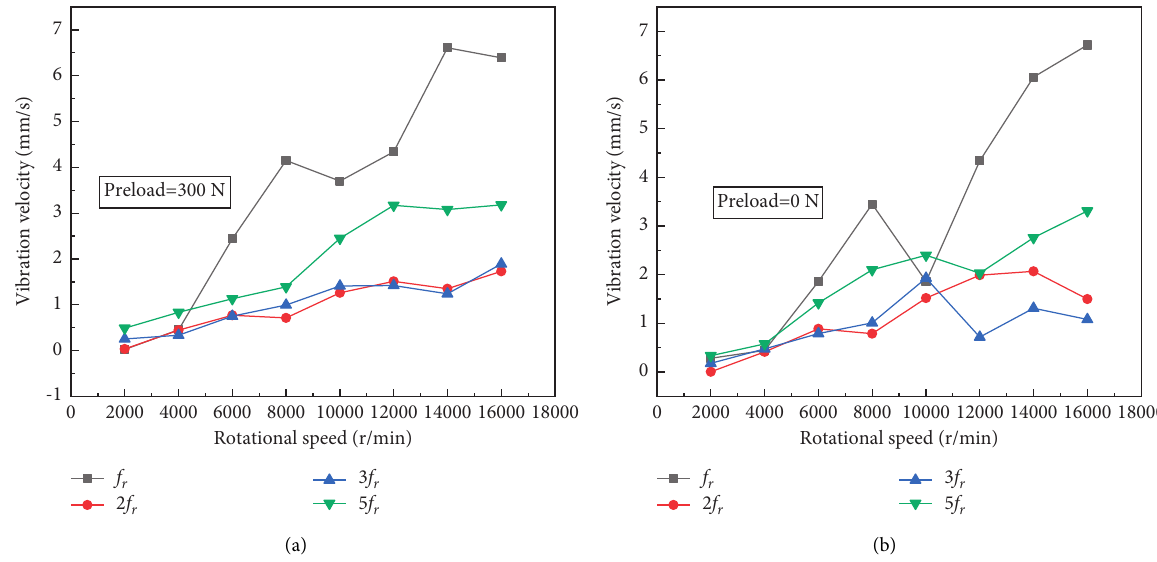
Figure 9: Effect of frequency multiplication on the vibration velocity for Si (a) Condition of applying preload. (b) Condition of no